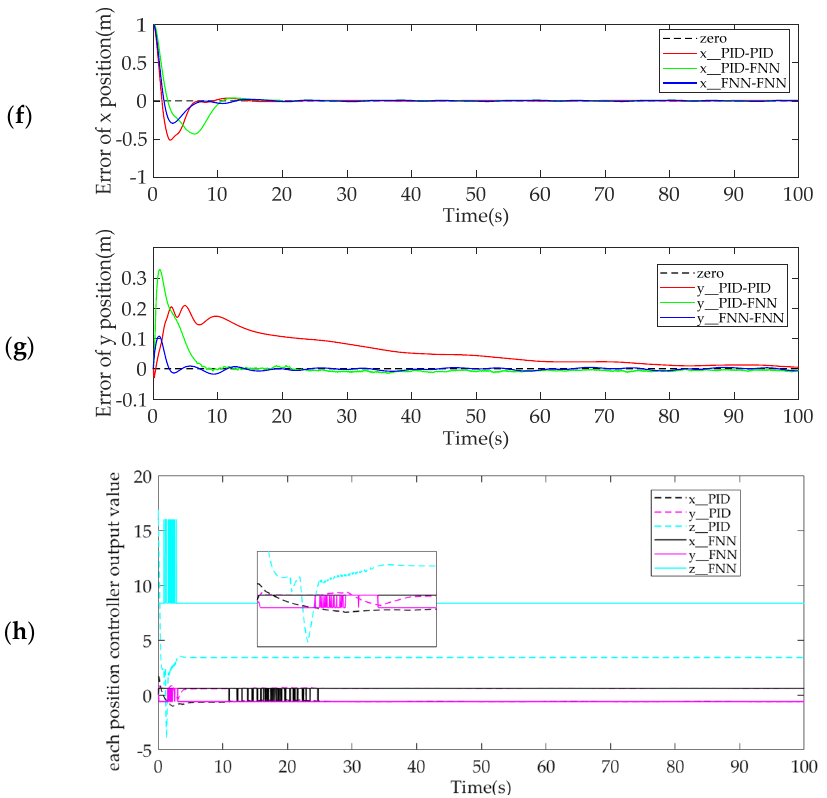
Figure 7. Results of a spiral trajectory tracking simulation. ( a ) x position, ( b ) y position, ( c ) z position, ( d ) yaw angle, ( e ) 3D spiral trajectory tracking simulation, ( f ) error of x position, ( g ) error of y position, and ( h ) outputs of position controllers.